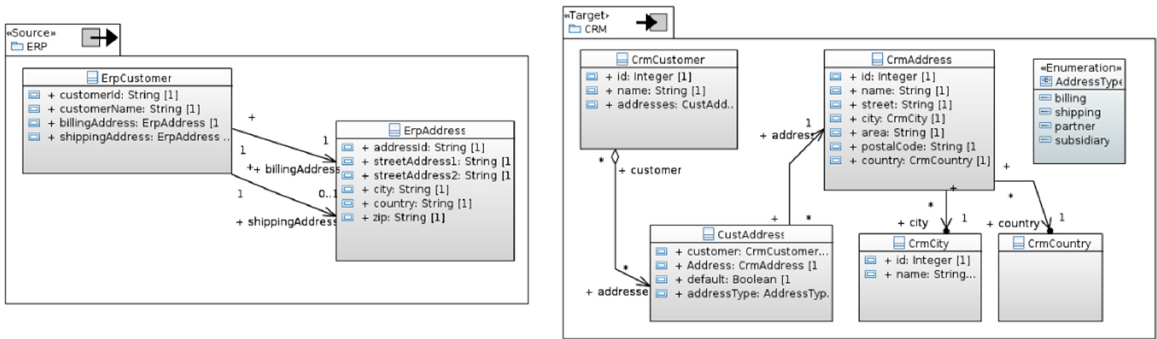
Figure 9. ERP source data model ( left ) and CRM target data model ( right ) with associations also shown as properties in the class definition.